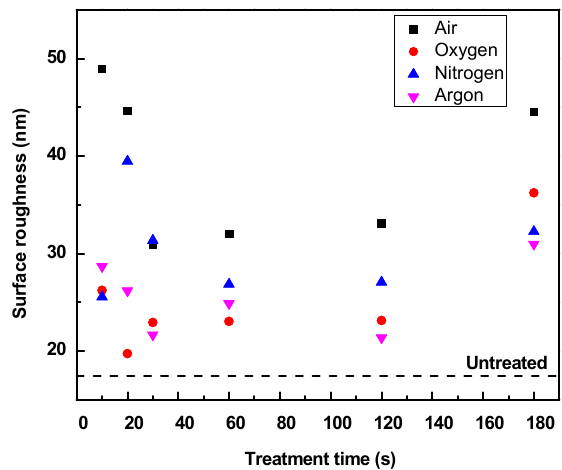
Figure 22. Surface roughness of plasma treated LDPE using air, oxygen, nitrogen, and argon.